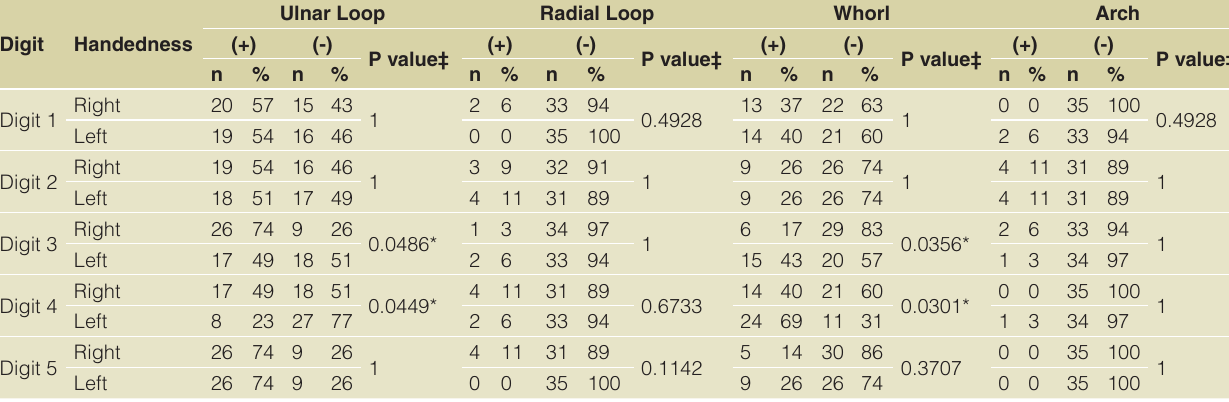
Table 3. Digital dermatoglyphic pattern distribution in right hand of